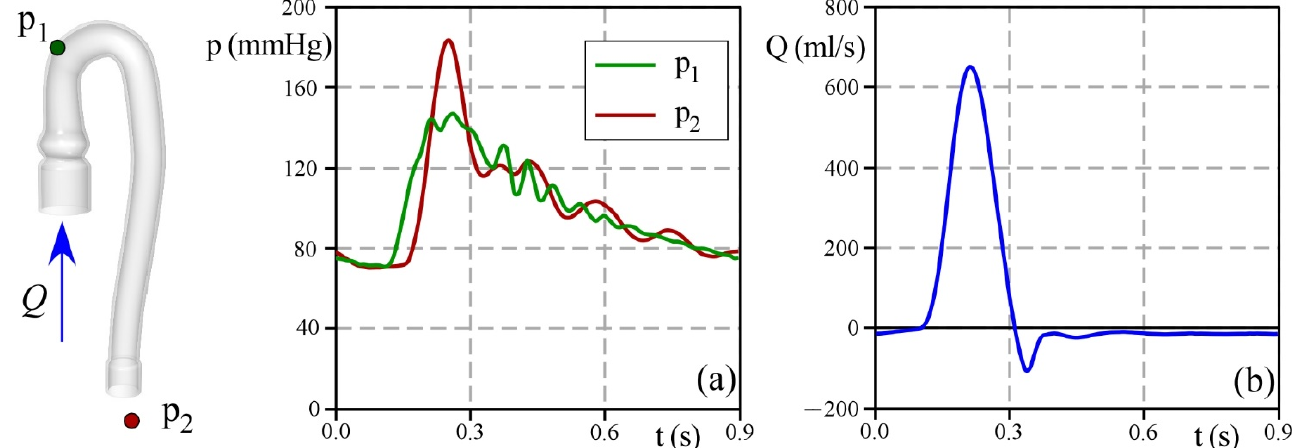
Figure 5. Measures collected in the hydrodynamics test: ( a ) Pressures collected by the probes p 1 (green line) and p 2 (red line), and ( b ) flowrate recorded by the flowsensor (blue line).